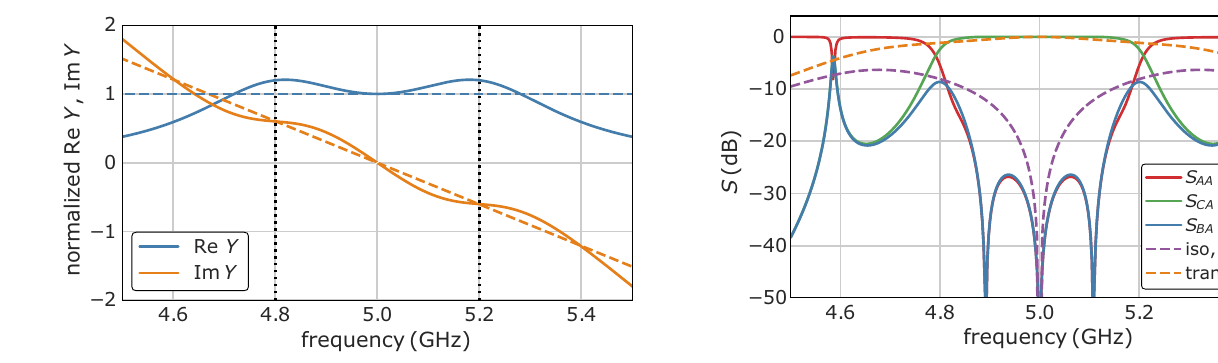
FIG. 18. S parameters of a broadband matched parametric cir- culator. Here S AA (red) is the reflection from port A , and S CA (green) and S BA (blue) are forward and reverse transmissions, respectively. Dashed lines show the forward transmission and reverse isolation of a bare three-mode circulator having the same γ 0